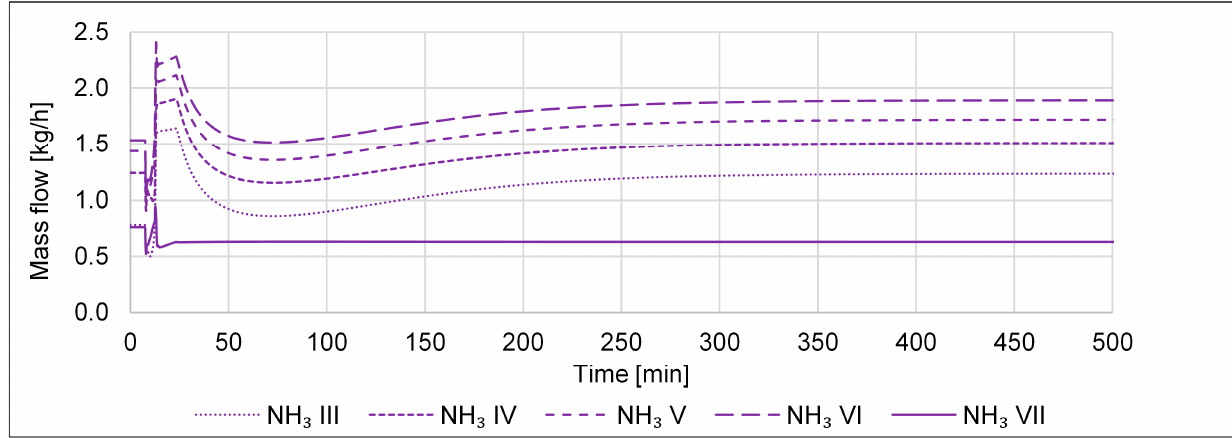
Figure 29 . Selected NH3 mass fl ows of scenario (j). Figure 29. Selected NH3 mass flows of scenario